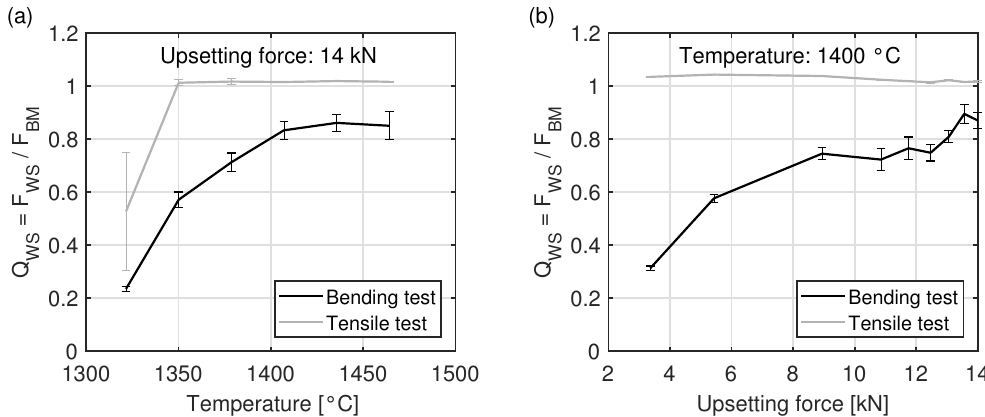
Figure 9. Dependence of the weld seam strength ratio Q WS ( a ) on the temperature at a constant upsetting force and ( b ) on the upsetting force at a constant